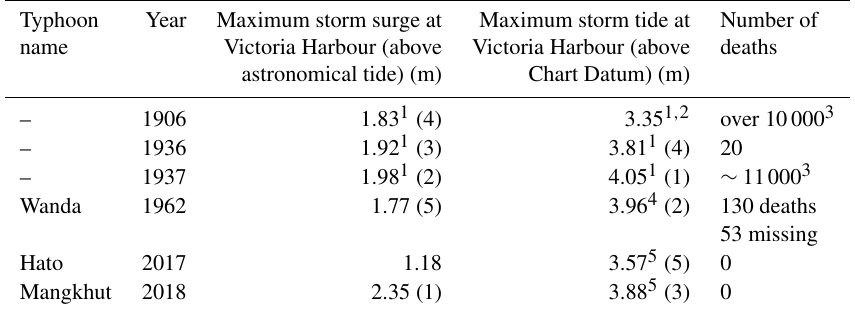
Table 1. Records of the top five storm surges and storm tides recorded in the Victoria Harbour in Hong Kong since the establishment of the Hong Kong Observatory in 1883 in chronological order. (The ranking of the top five is shown in parentheses.)